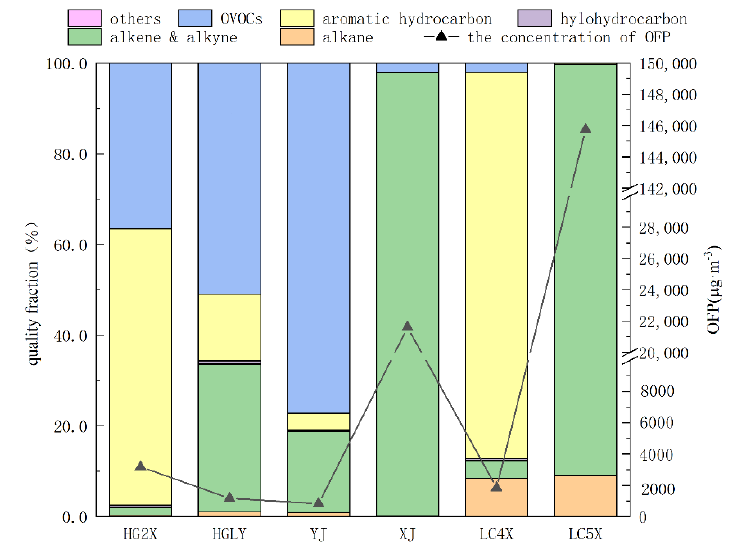
Figure 2. OFP values of VOCs from six circulating cooling water